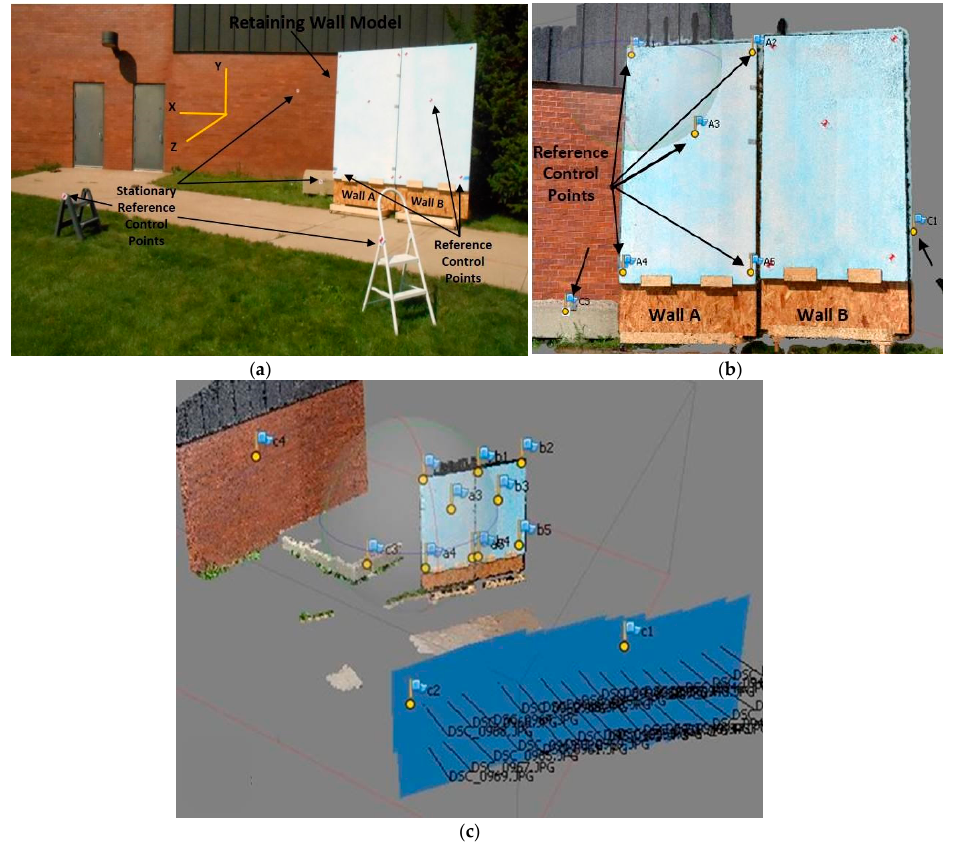
Figure 2. ( a ) Image of the retaining wall model and surrounding control points during data collection; ( b ) point cloud creation for the model with the reference control points (highlighted as flagged points on wall A); and ( c ) visualization of the point cloud (with referenced control points) and camera positions during image collection.